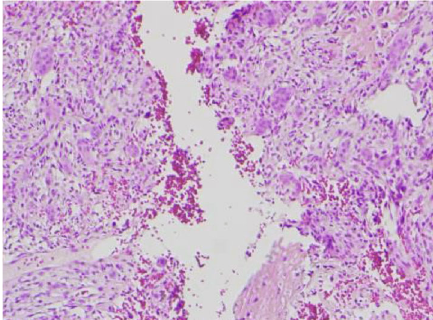
Figure 1: Cellular fi brous septa containing uniform fi broblasts with scattered osteoclast-like giant cells adjacent to an area with prominent reactive woven bone deposition in subperiosteal ABC (H&E, 10x).